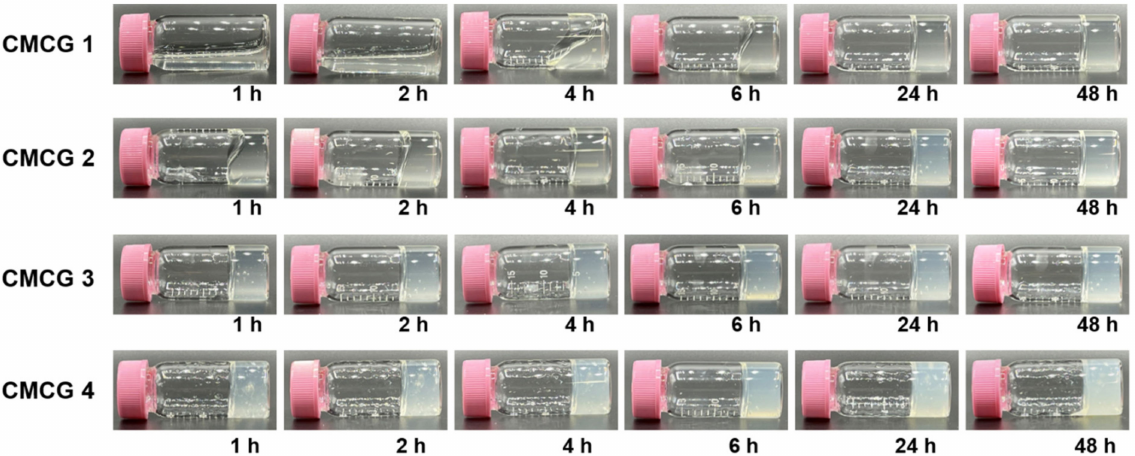
Figure 5. Photographic images of the reaction mixtures for the preparation of carboxymethyl chitosan hydrogels (CMCG 1–4) after 1, 2, 4, 6, 24, and 48 h of cross-linking between carboxymethyl chitosan and the oxidized sucrose.